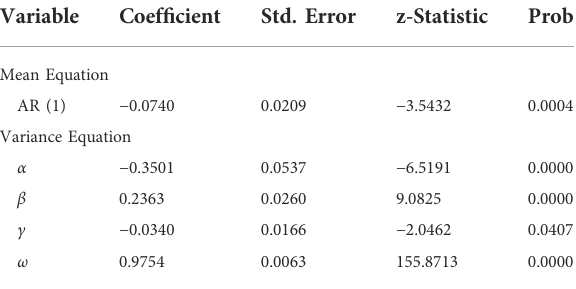
TABLE 6 Estimation results of the EGARCH (1, 1) model for Hubei spot returns from 1 July 2019, to 30 July 2021.